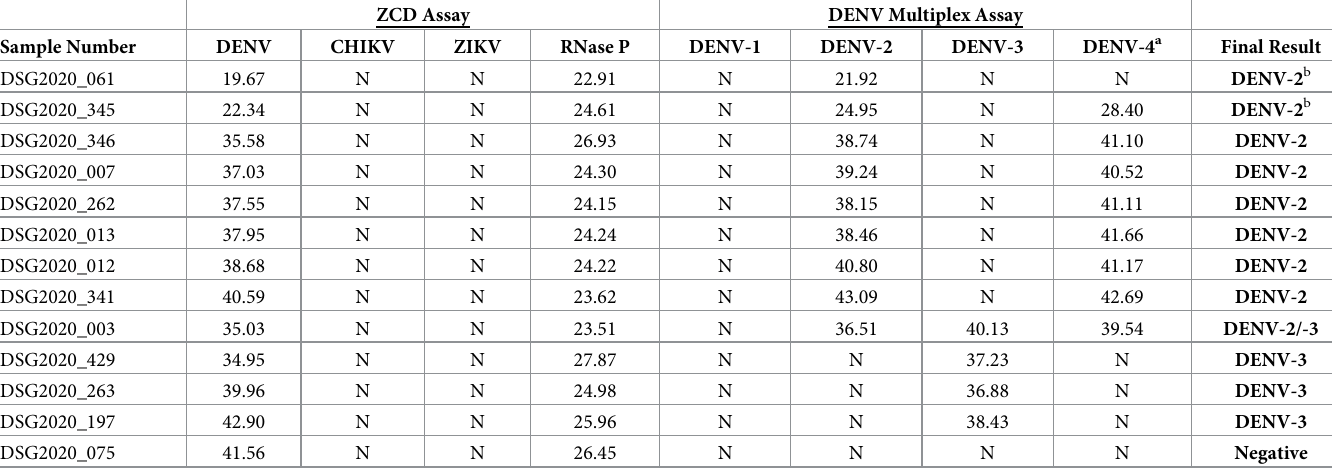
Table 2. rRT-PCR results for DBS samples positive for DENV RNA.